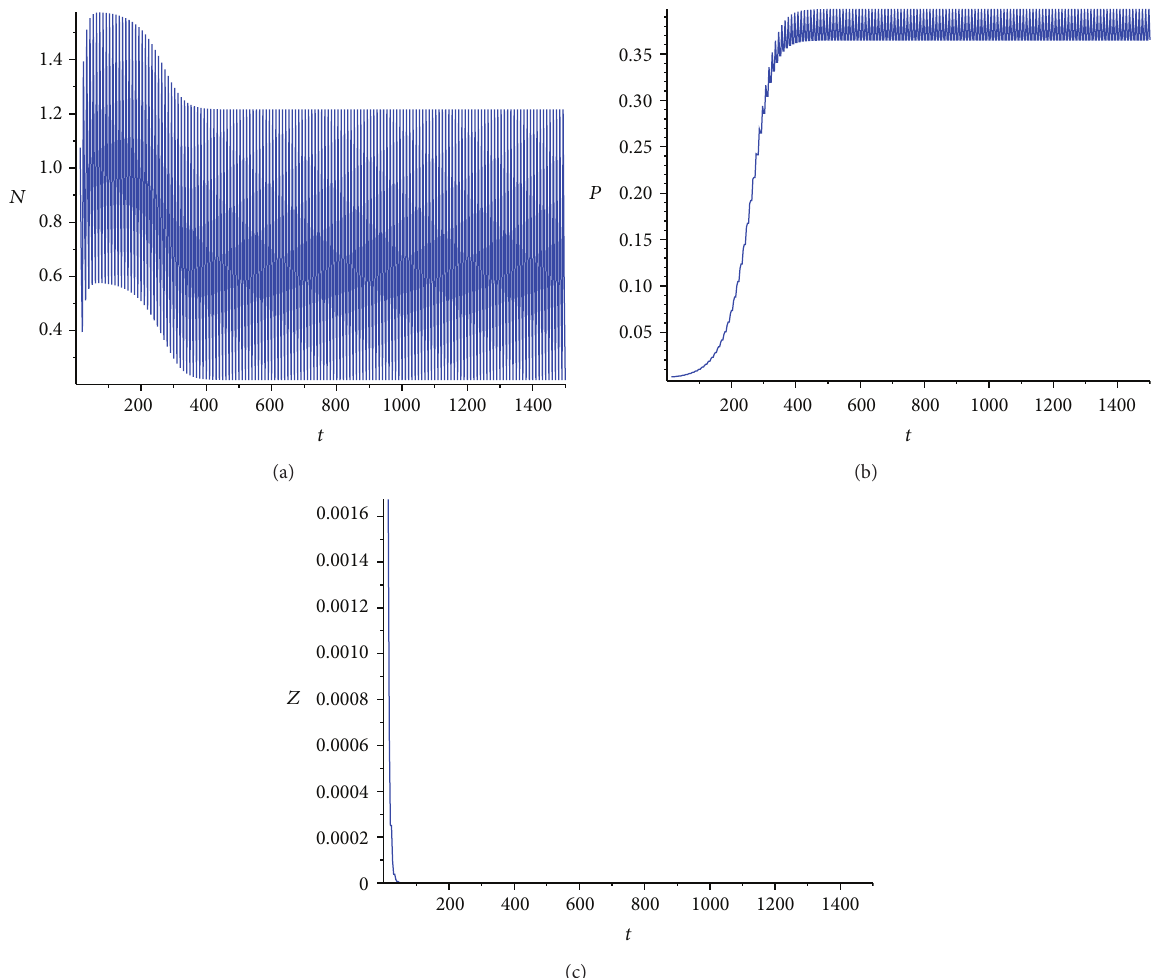
Figure 5: Existence of the periodic boundary solution (𝑁(𝑡),𝑃(𝑡),0) of system (22). (a), (b), and (c) are time series of nutrient, phytoplankton, and zooplankton, respectively, where 𝜆 = 1.5